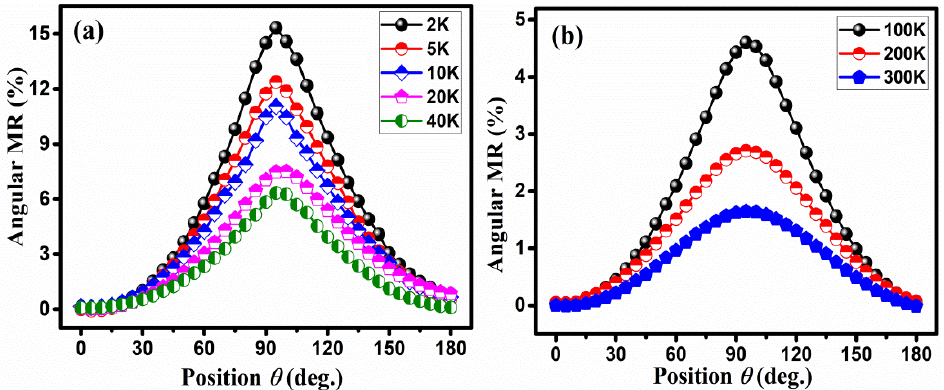
Figure 5. The angular MR (%) vs. the position θ of the sample S10 at B = 7 T ( a ) from 2 K to 40 K; ( b ) from 100 K to 300 K.